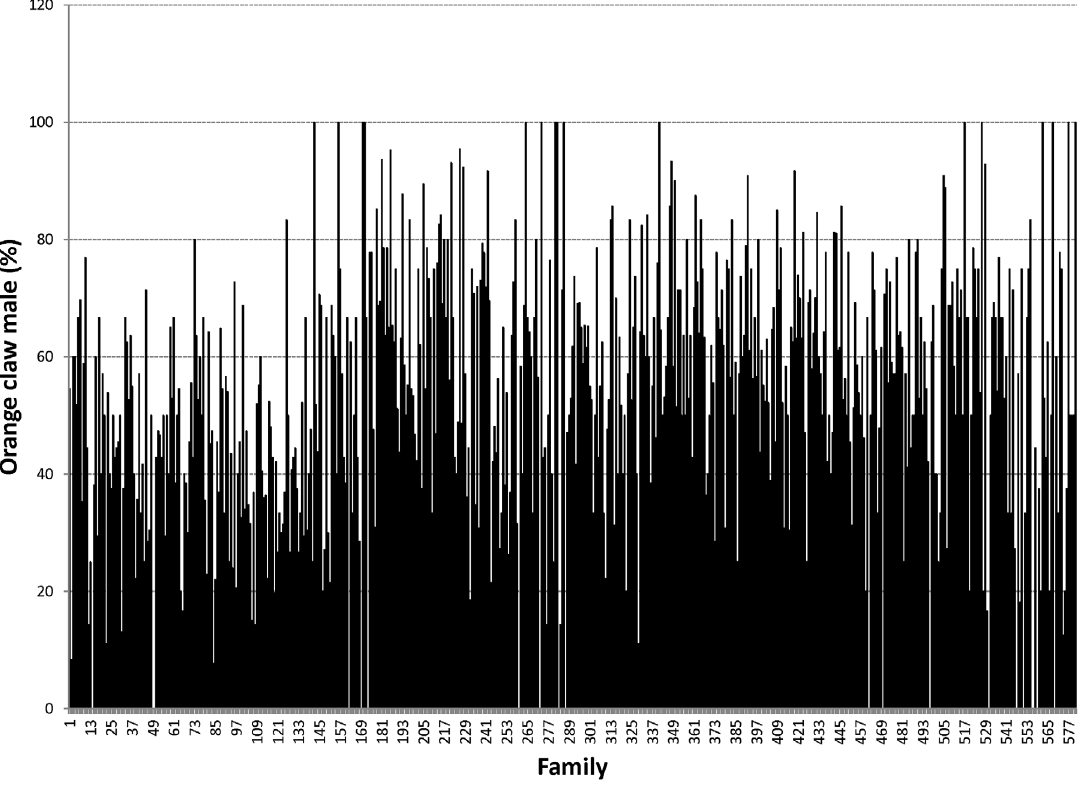
Figure 2. Orange claw male.